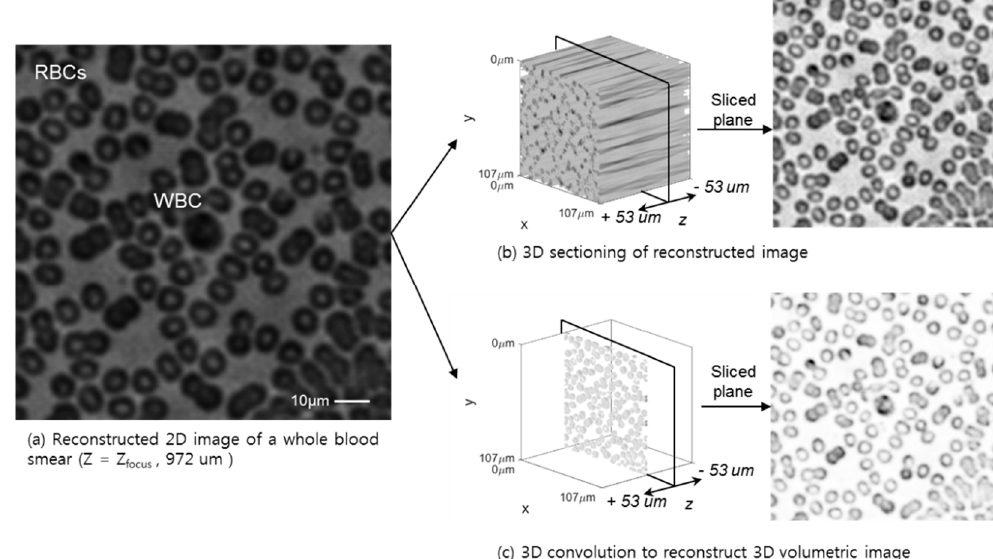
Figure 6. For real biological sample tests, whole blood images at Z focus = 972 um ( a ), are reconstructed by 2D ( b ) and 3D ( c ) volumetric deconvolution. From a 2D hologram image, high-resolution 3D whole blood cells can be identified as red blood cells and white blood cells, which show a clear image of a nucleus. Complete information about the intensity and phase in the cell structure also aids identification according to the refractive index. The 3D convolution method shows more of the volumetric feature of the blood cells than the 2D approach.